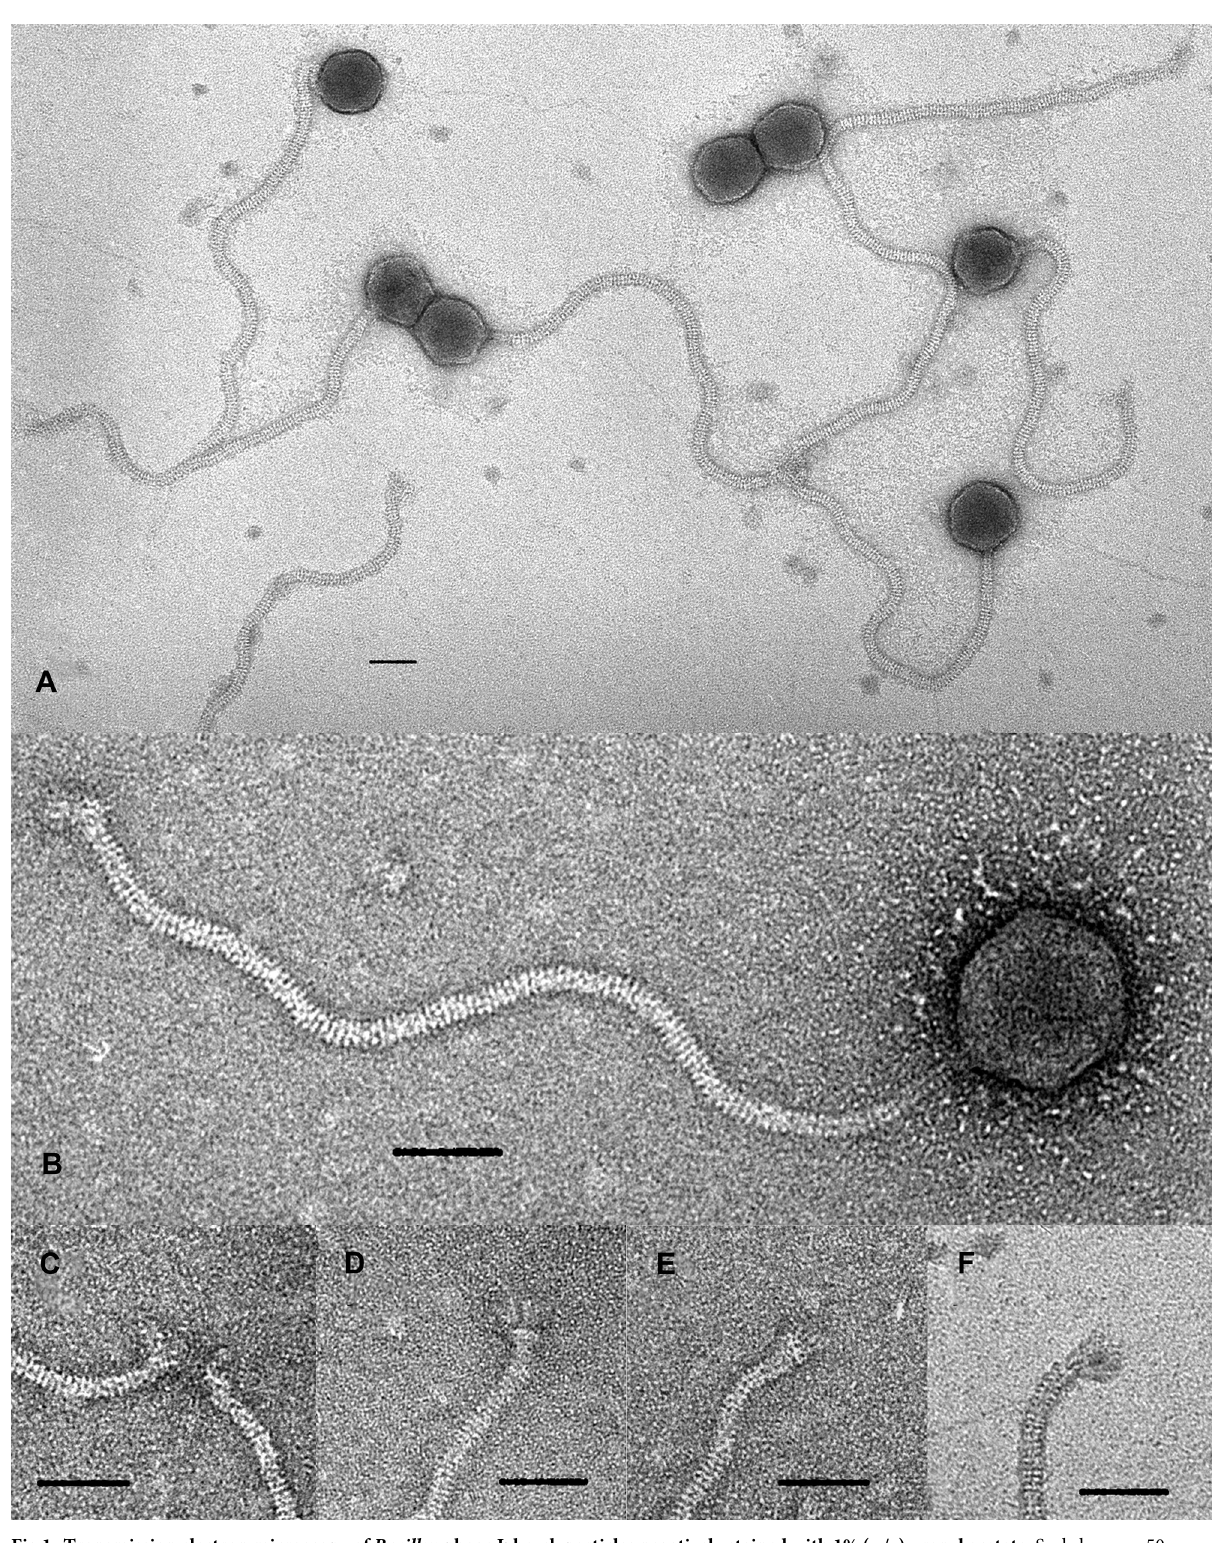
Fig 1. Transmission electron microscopy of Bacillus phage Izhevsk particles negatively stained with 1% (w/v) uranyl acetate. Scale bars are 50 nm. A. The bacteriophage particles. B. Closeup view of a single phage particle. C-F. Baseplate and fiber-like structures, closeup view.